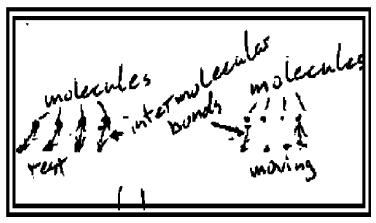
FIG. 7. Breaking of bonds causes friction.